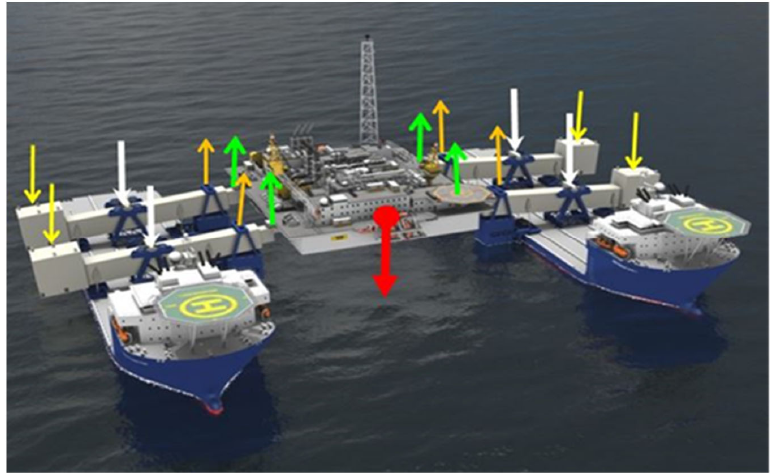
Figure 2. Illustration of the Lifting Principle.